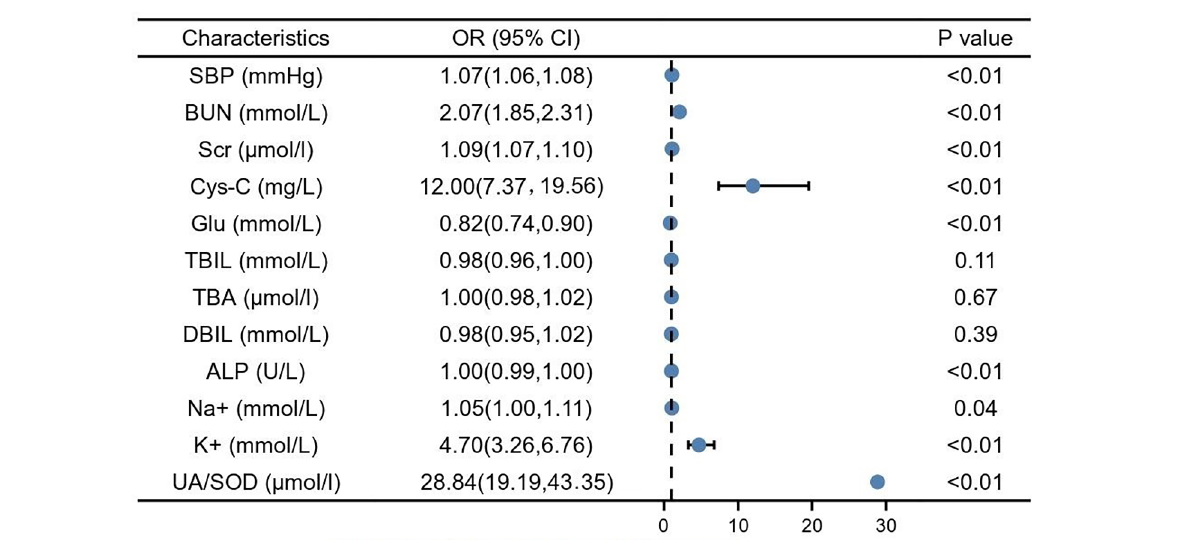
FIGURE 1 Single factor logistic analysis. SBP, systolic blood pressure; BUN, blood urea nitrogen; Scr, serum creatinine; Cys-C, cystain C; Glu, glucose; TBIL, total bilirubin; TBA, total bile acid; DBIL, direct bilirubin; ALP, alkaline phosphatase; Na+, natrium; K+, potassium; UA, blood uric acid; SOD, superoxide